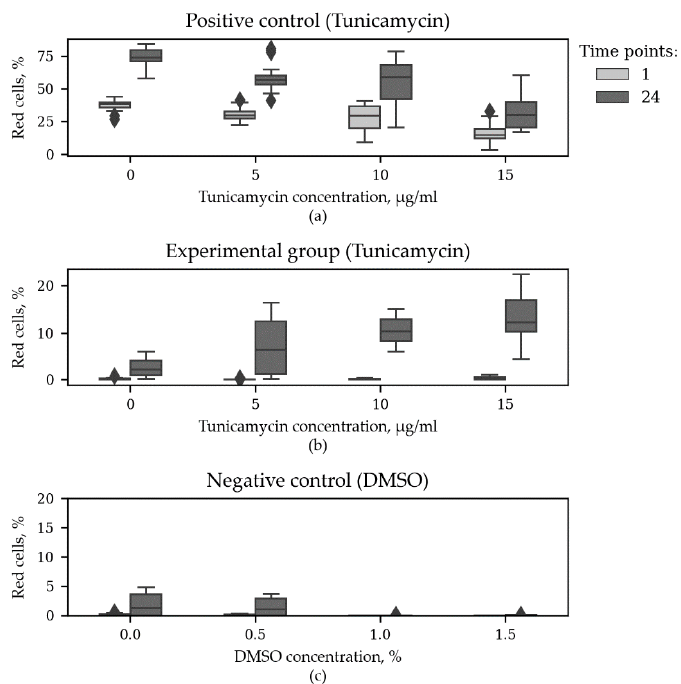
Figure 6. Red cell percentage in the beginning and at the end of the second ER stress time course. ( a ) Positive control group with constantly expressed TagRFP treated with different concentrations of tunicamycin; ( b ) Experimental group responsive to ER stress conditions treated with different concentrations of tunicamycin; ( c ) Negative control group treated with different concentrations of DMSO. N = 18. The horizontal axes correspond to Tunycamycin ( a , b ) and DMSO ( c ) concentrations.